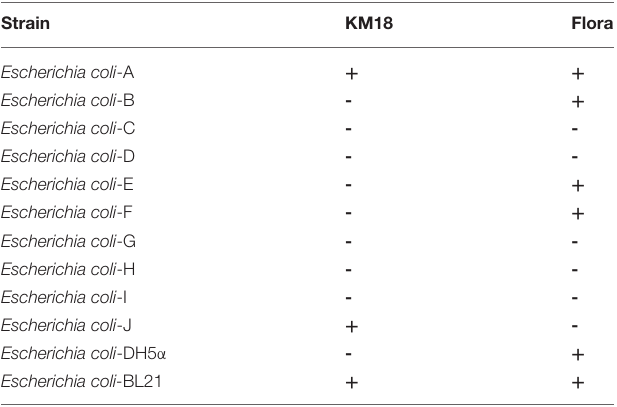
TABLE 2 | Host range analysis of phages KM18 and Flora.